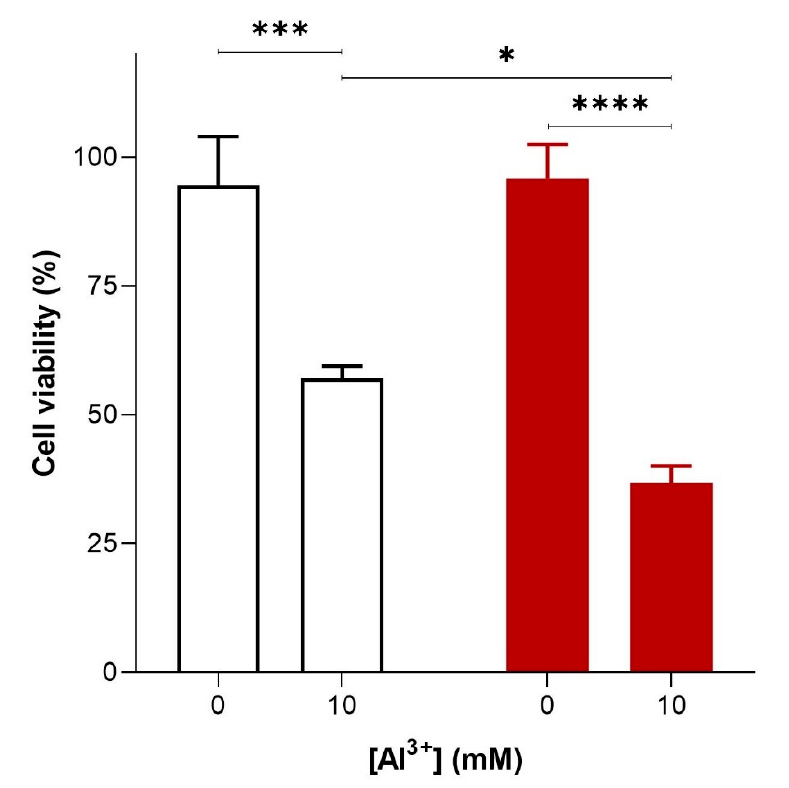
Figure 2. Al 3+ -mediated cell killing of Saccharomyces cerevisiae transformant strains BY4743 [p416GPD.GFP] (white bar) and BY4743 [p416GPD.GFPA β ] (red bar). S. cerevisiae transformant strains BY4743 [p416GPD.GFP] and BY4743 [p416GPD.GFPA β ] were suspended in water and treated with 10 mM Al2(SO4)3. After 24 h, cells were plated on yeast extract peptone dextrose (YEPD) and incubated for 4 days at 30 ◦ C to determine cell viability. Values are from triplicates; the mean and standard deviation are shown. Values significantly different from 0 mM Al 3+ and between the two transformant strains in a two-way ANOVA with Tukey’s post hoc analysis are indicated with asterisks: * p < 0.01, *** p < 0.0003, **** p < 0.0001.